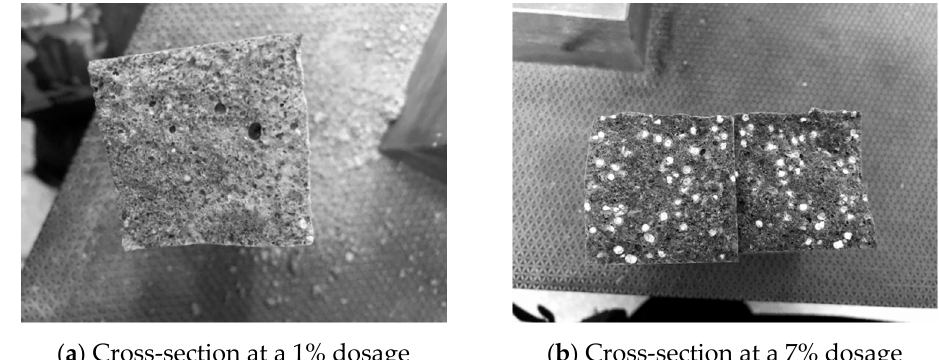
Figure 6. ( a , b ) A section of microcapsule self- healing cement specimen.